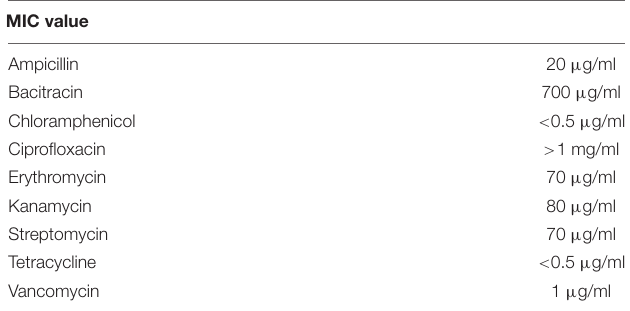
TABLE 7 | Alicyclobacillus mali FL18 susceptibility to